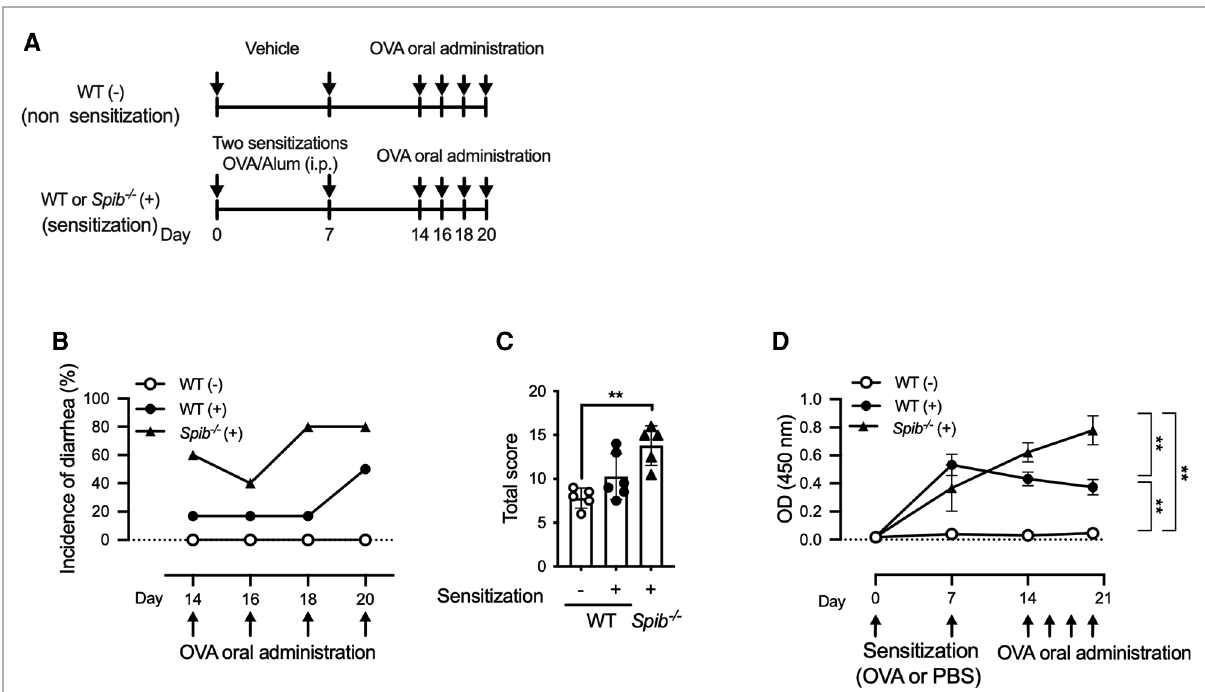
FIGURE 1 Spi-B de fi ciency exacerbates the symptoms of OVA-induced food allergy. ( A ) Experimental design for sensitization and oral administration of OVA to develop a food allergy model. ( B,C ) Fecal consistency was visually examined within 1 h of each oral OVA administration to determine the fecal score. The incidence of diarrhea was indicated by the fecal score of 4 ( B ) and total fecal scores during Day 14 – 20 ( C ). ( D ) Time course of OVA-speci fi c IgE production after OVA sensitization. Serum samples were collected on the indicated days to measure OVA-speci fi c IgE levels. Representative data from at least three independent experiments are shown. Data are expressed as the mean±SEM ( n =5 or 6). ( C,D ) ** p <0.01, calculated using the Kruskal – Wallis test and two-way